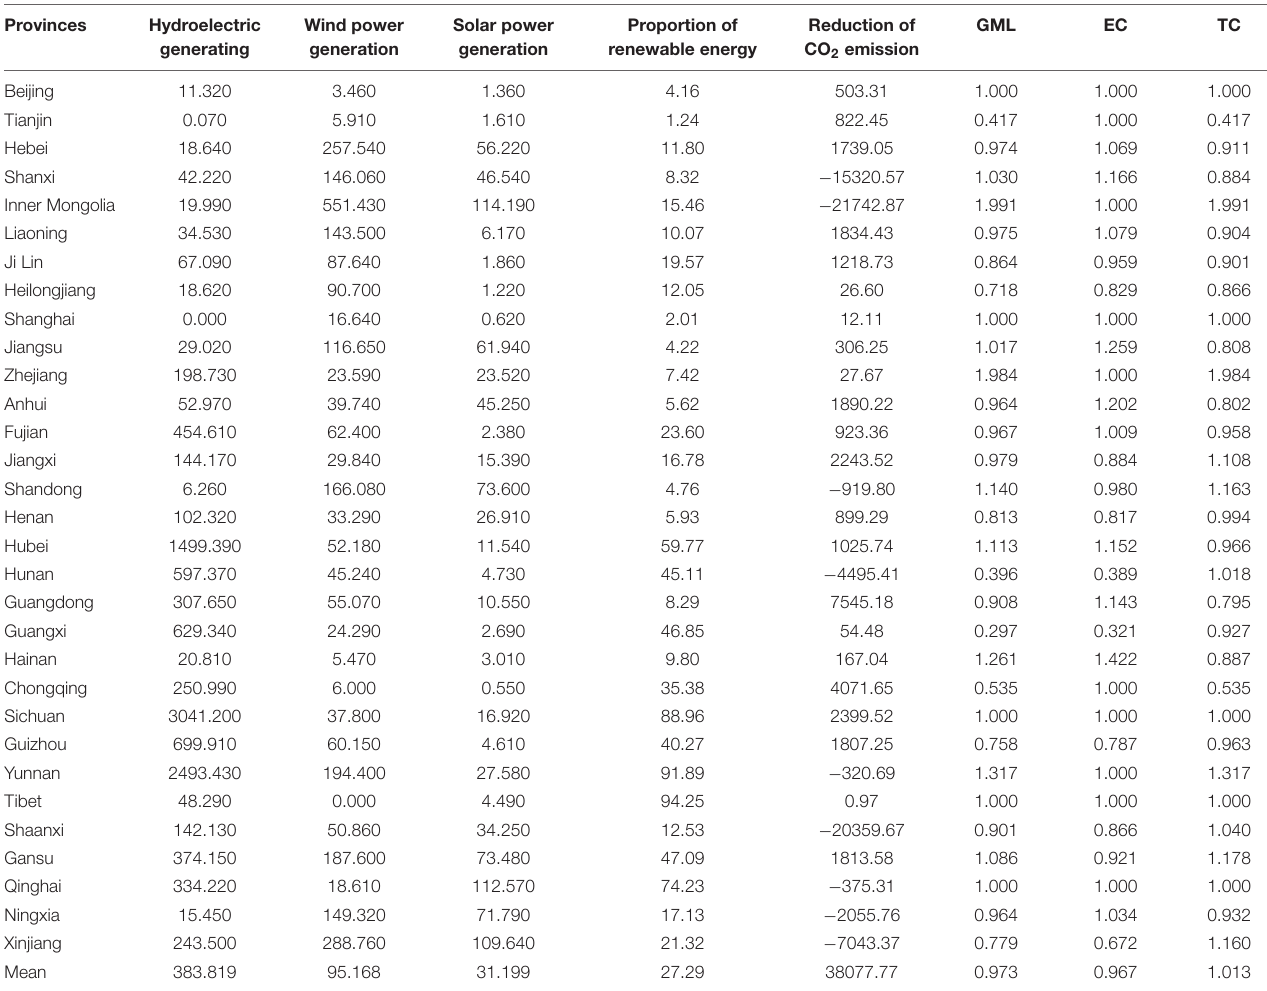
TABLE 3 | China’s regional renewable energy structure and energy development environmental endowment index in 2017.